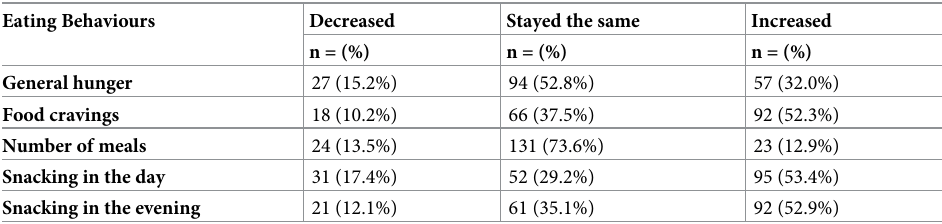
Table 2. Changes in reported levels of dietary behaviours. Eating Behaviours Decreased Stayed the same Increased n = (%) n = (%) n = (%) General hunger 27 (15.2%) Food cravings Number of meals Snacking in the day Snacking in the